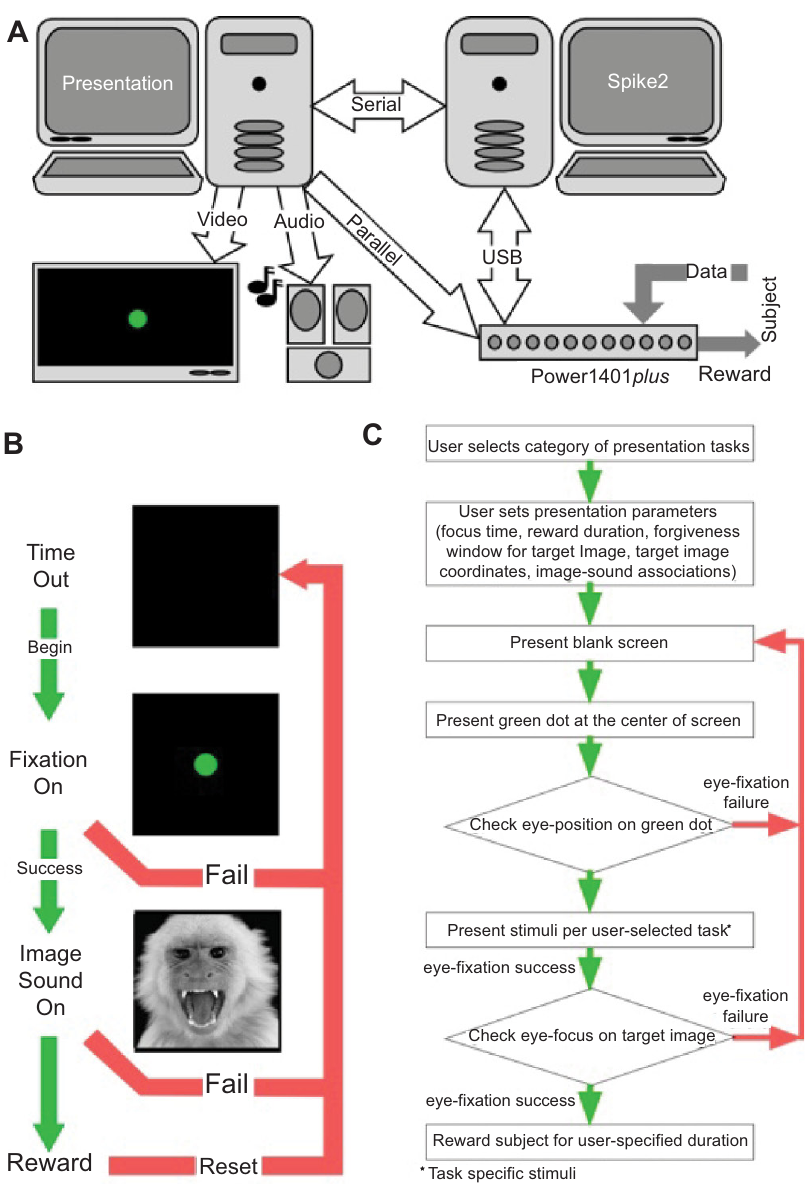
Figure 1. System hardware connectivity and experiment flow chart . A . The system is divided into three levels: Data Acquisition and Behavioral Monitoring, Stimulus Presentation Control, and Stimulus Presentation. B . Typical flow of experiment based on performance of subjects. C . Logical flow chart for behavioral tasks used in the training and testing paradigms. Table 1. A list of computer and electronic items used in our stimulus presentation, behavioral monitoring, and protocol control system (standard data acquisition and electronic equipment used for electrophysiology is not listed